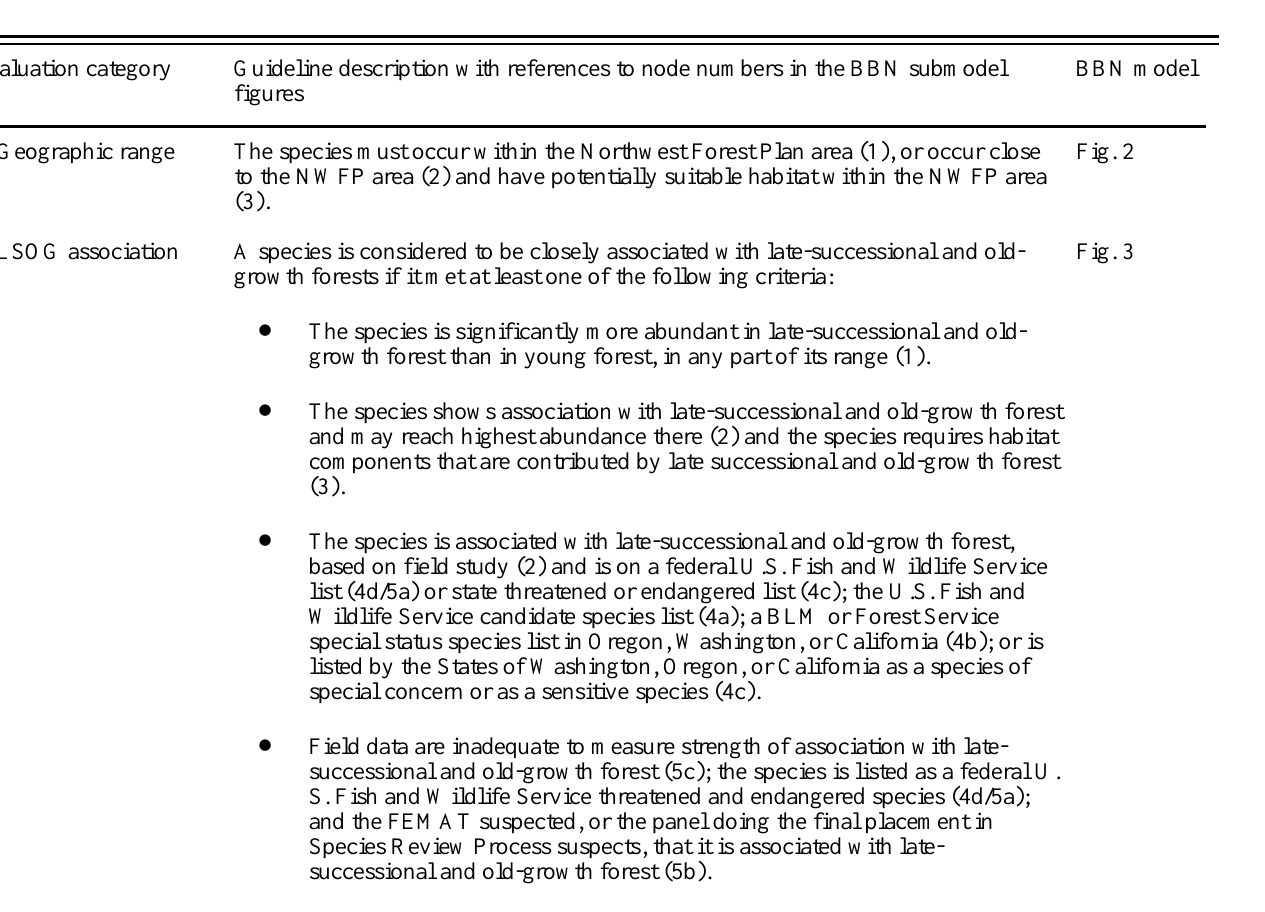
Table 2. Guidelines for evaluating species persistence and late successional and old-growth forest (LSOG) association under the Northwest Forest Plan (NWFP), taken from USDA and USDI (2001), with reference to the Bayesian belief network (BBN) decision models. See Fig. 1 for how the overall BBN decision model combined these six evaluation categories. BLM = USDI Bureau of Land Management, and FEMAT = Forest Ecosystem Management Assessment